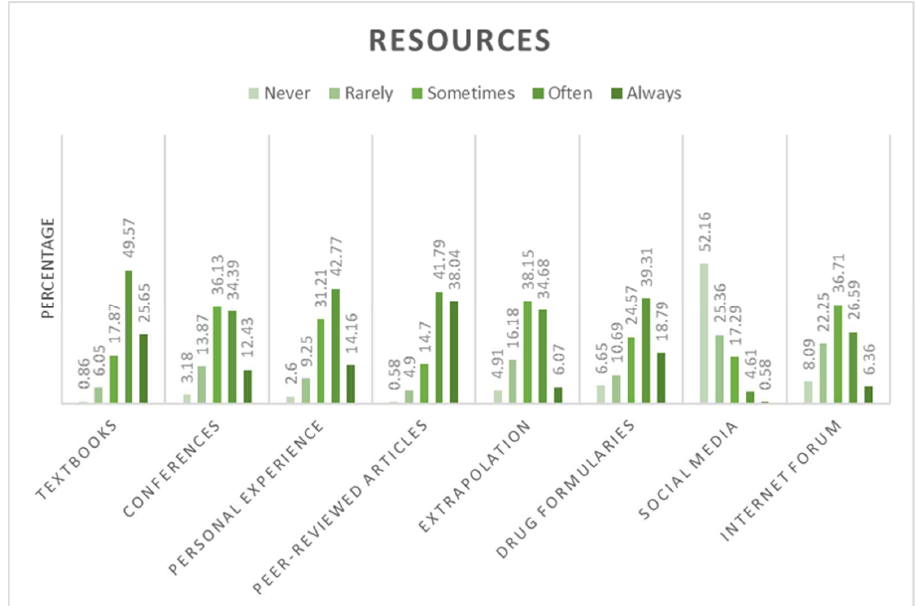
Figure 2. Resources used by the respondents ( n = 417) to obtain information about analgesia and locoregional anaesthesia as it applies to non-conventional animal species. Extrapolation: extrapolation of techniques and drug doses from domestic animal species. The percentages on the y -axis indicate the proportions of veterinarians who reportedly used each specific resource on the x -axis. Never, rarely, sometimes, often and always indicate the frequency of use of the resources listed on the x -axis.